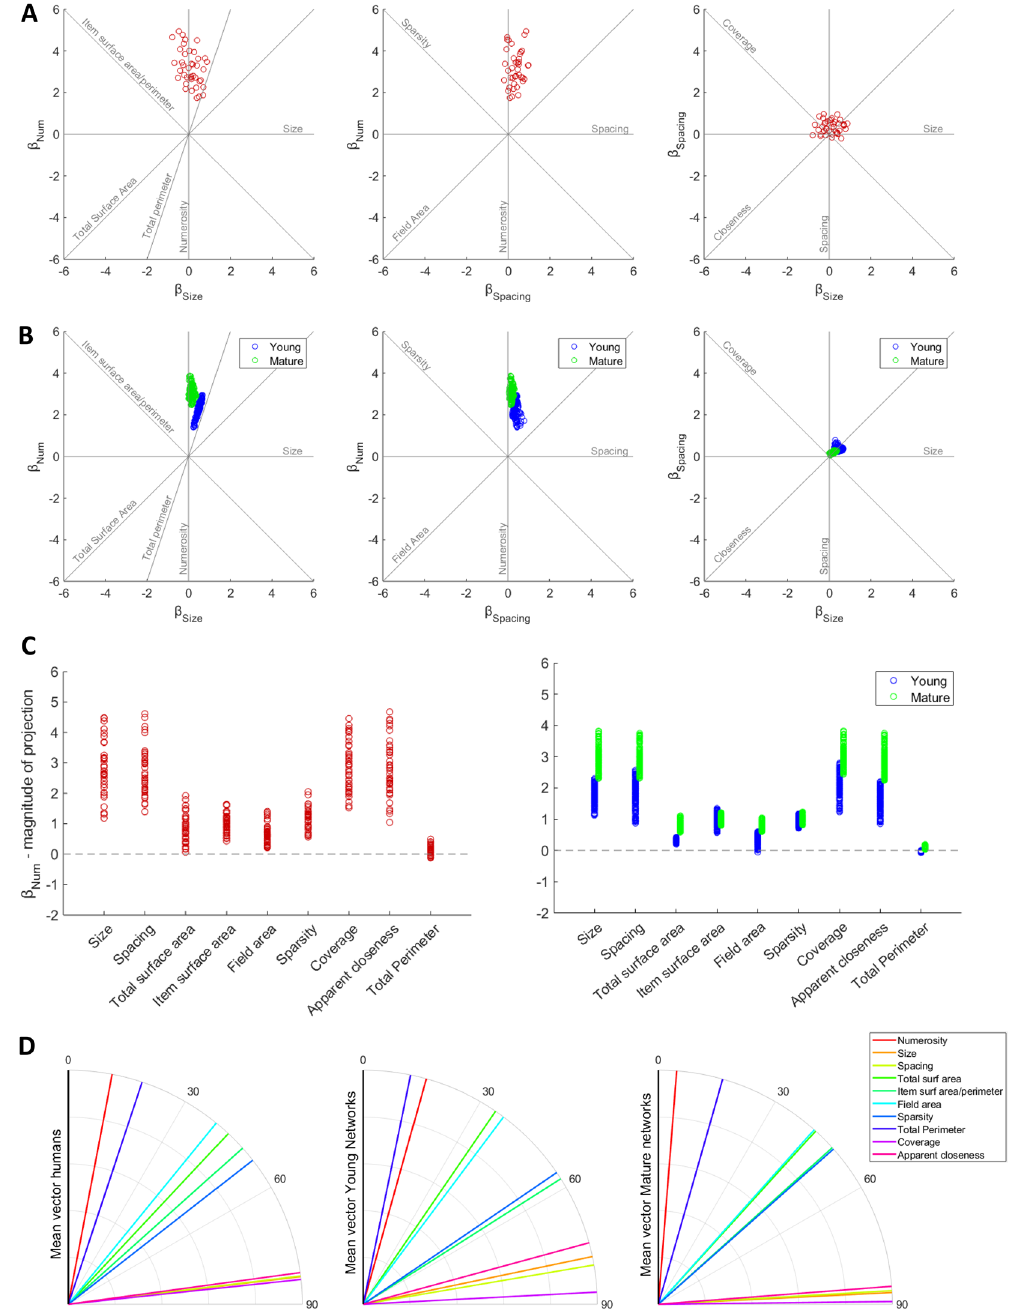
Figure 2. Psychophysics of numerosity comparison in humans and deep networks. Scatter plots of Numerosity, Size and Spacing coefficients for humans ( A ) and all deep networks ( B ), also showing the axes of individual features as done in 41 . ( C ) Differences between the projection on the Numerosity dimension and the projections on all individual non-numerical features for humans (left) and deep networks (right). Positive values indicate that number was a better predictor of behavior than the specific feature. Negative values would indicate that the considered feature had greater impact on discrimination choice. ( D ) Angles between the discrimination vector and all non-numerical features (the discrimination vector is on the y axis) for humans (left) and deep networks at two different developmental stages: Young (middle) and Mature